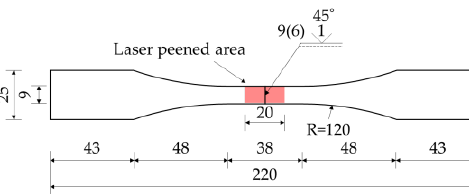
Figure 13. Butt-welded specimen for fatigue test.